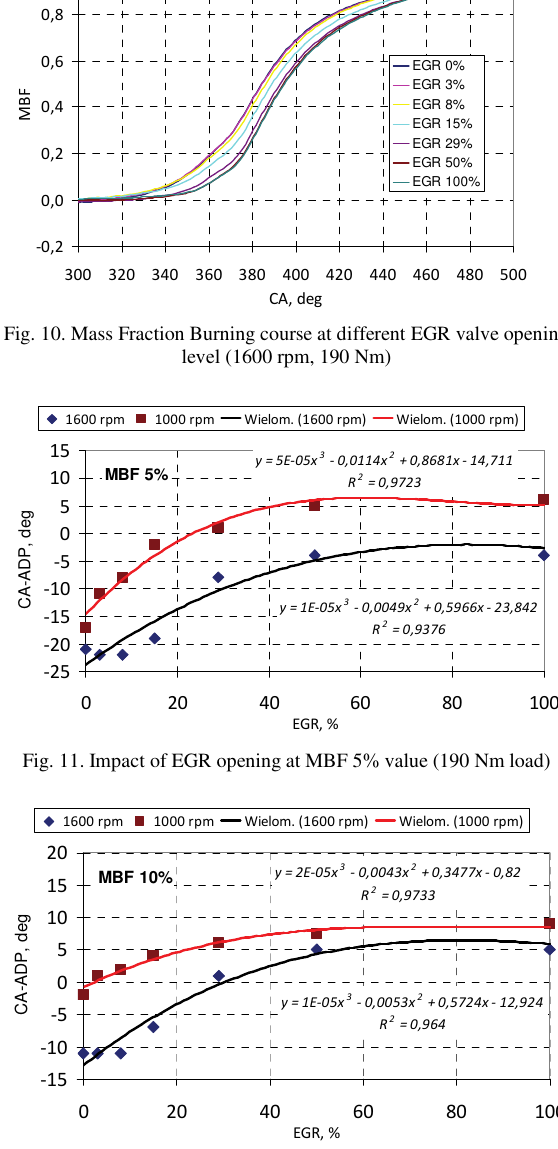
Fig. 12. Impact of EGR opening at MBF 10% value (190 Nm